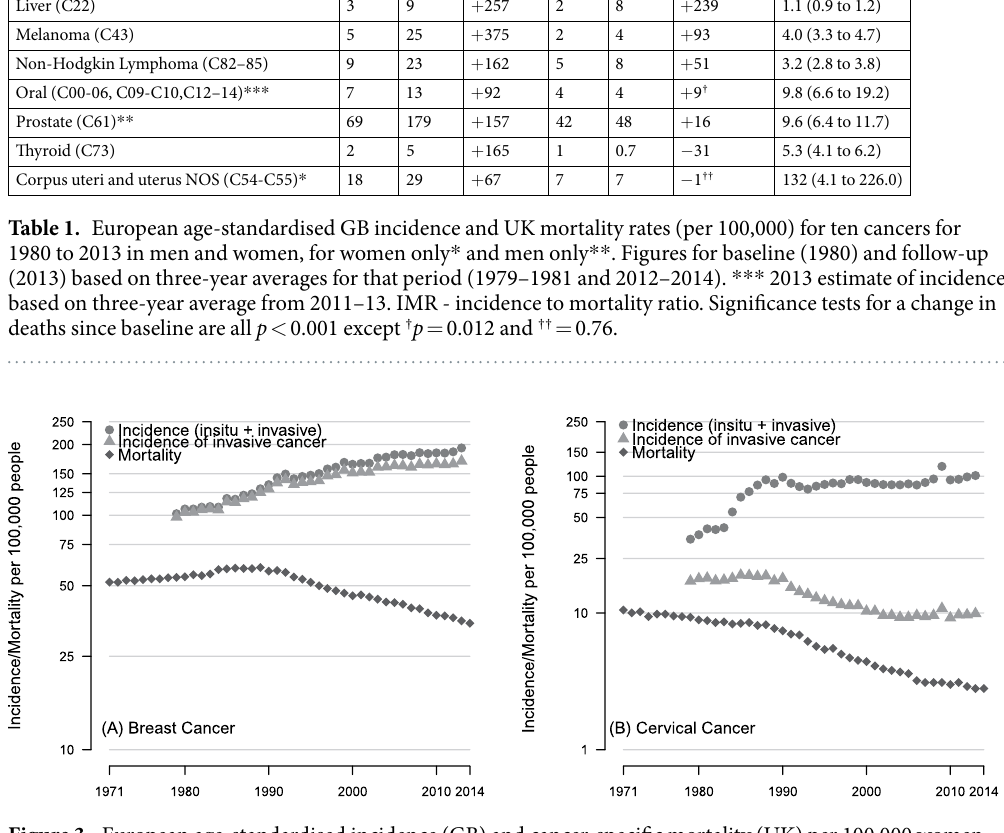
Figure 3. European age-standardised incidence (GB) and cancer-specific mortality (UK) per 100,000 women for ( A ) breast cancer (ICD 10 codes C50 and D05) and ( B ) cervical cancer (C53 and